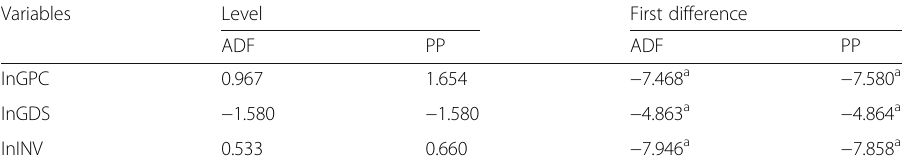
Table 1 Augmented Dickey – Fuller (ADF) and Phillips – Perron (PP) unit root tests Variables Level First difference ADF PP ADF PP InGPC 0.967